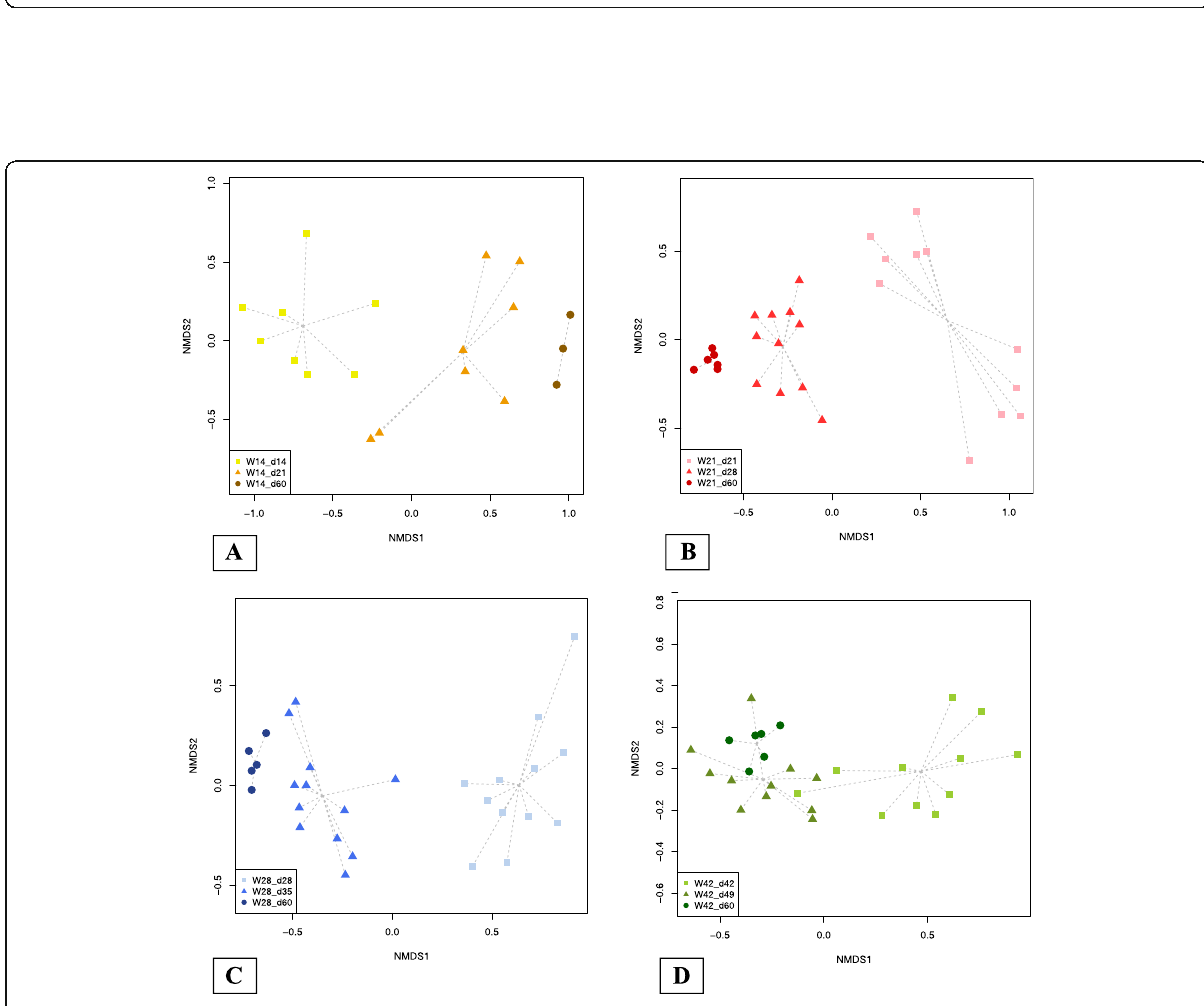
Fig. 4 NMDS plots showing microbiota composition at each sampling point within each weaning group ( a : piglets weaned at 14 days of age; b : piglets weaned at 21 days of age; c : piglets weaned at 28 days of age; and d : piglets weaned at 42 days of age)